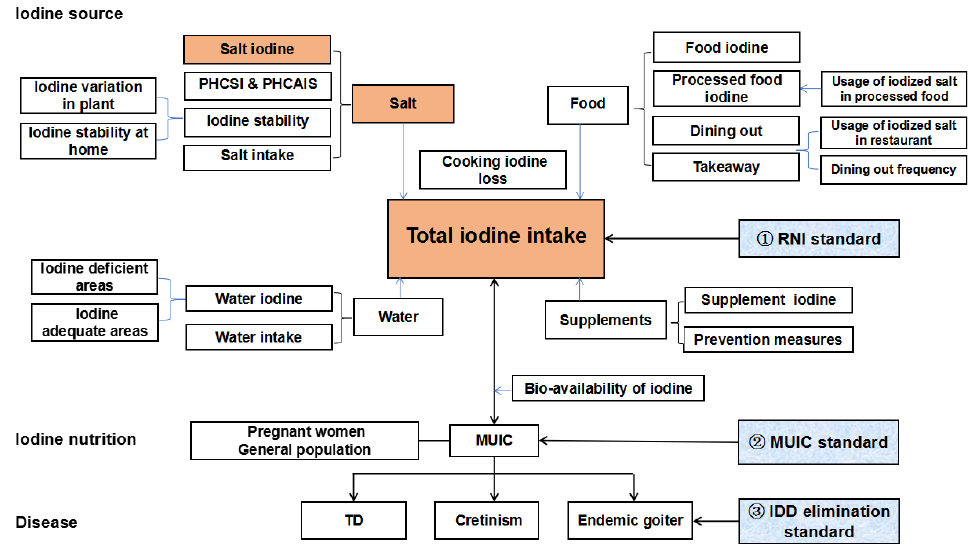
Figure 2. Indicator system for selecting the iodine content in salt. PHCSI, proportion of households consuming iodized salt; PHCAIS, proportion of households consuming adequate iodized salt; RNI, recommended nutrient intake; MUIC, median of urine iodine concentration; IDD, iodine deficiency disorder; TD, thyroid disease.